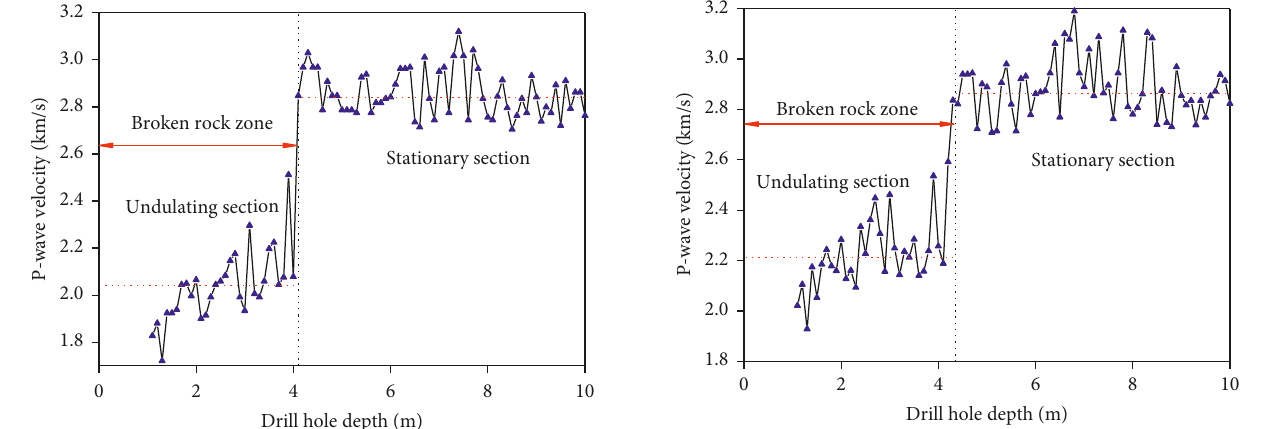
Figure 5: The relationship between the wave velocity and the depth of the drilling hole of the test point A.